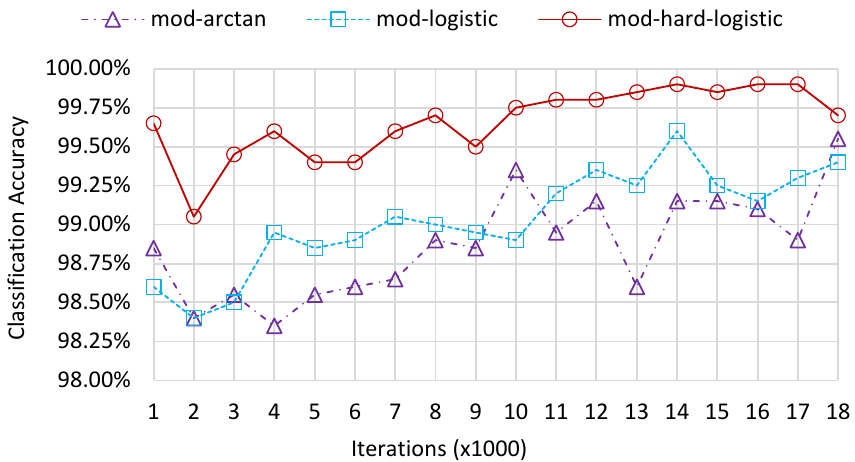
Figure 7. Clustering results of the leaf layer for MQAM with discrete transformation and differ- ent scales.